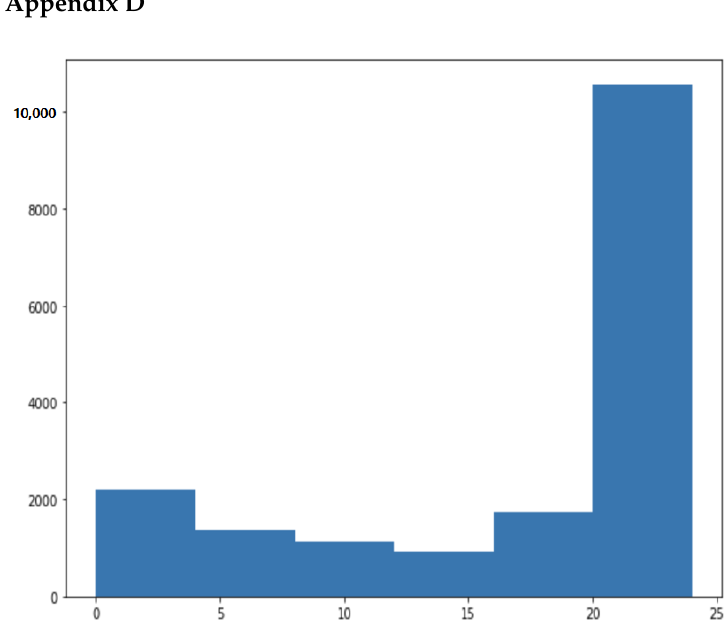
Figure A3. Daily GPS data distribution of individuals (24 h).